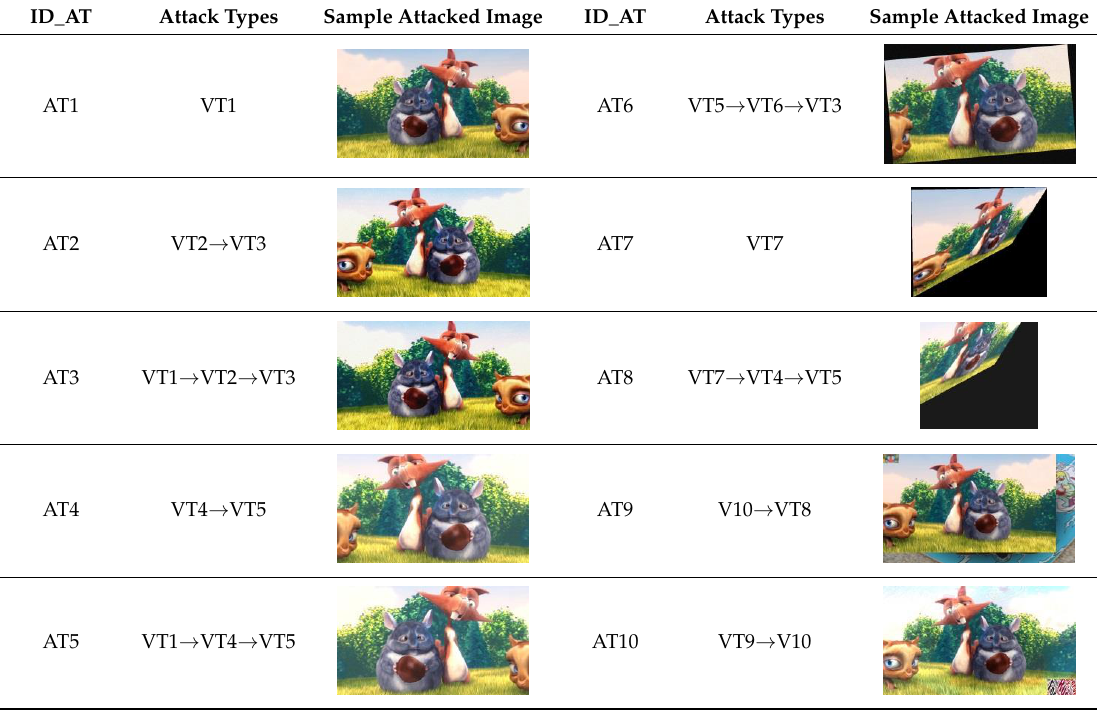
Table 19. The performed attacks on the test images for video searching.